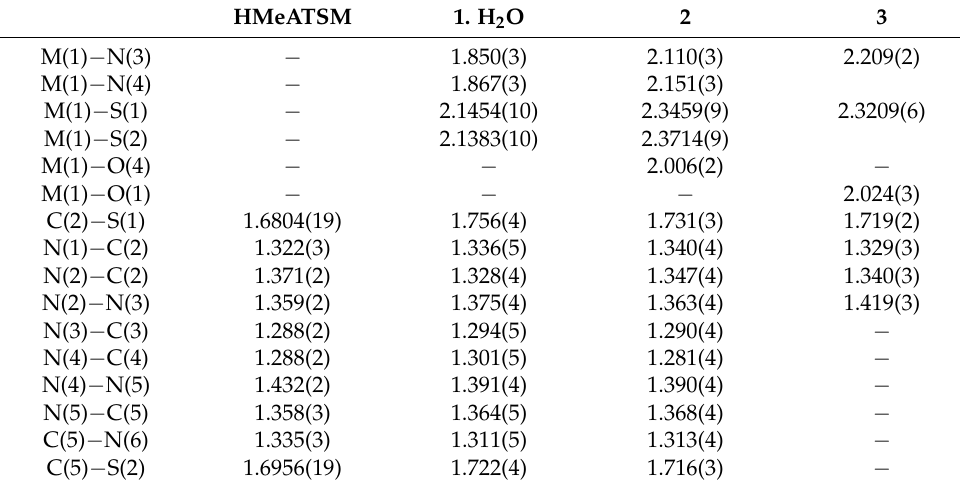
Table 2. Selected bond distances (Å) for HMeATSM, 1. H 2 O, 2 and